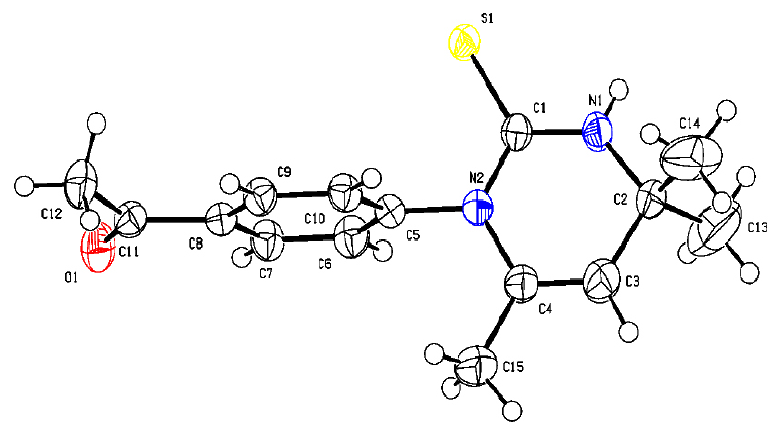
Figure 2. Molecular structure of title compound 4 with the atom numbering scheme. Thermal ellipsoids are drawn at the 50% probability level. The interatomic distances obtained from experimental X-ray diffraction were in ac- cordance with theoretical bond lengths obtained from DFT/B3LYP/6-31G*. Table 1 below summarizes interatomic distances. The bond lengths between carbon and hydrogen atoms are average 2.80 Å, whereas C-C bond length is 3.365 Å. When these values were com- pared with theoretical calculations, there was no significant difference between theoretical and experimentally obtained bond lengths. Then the correlation coefficient value was cal- culated for bond lengths, which was 0.9912.